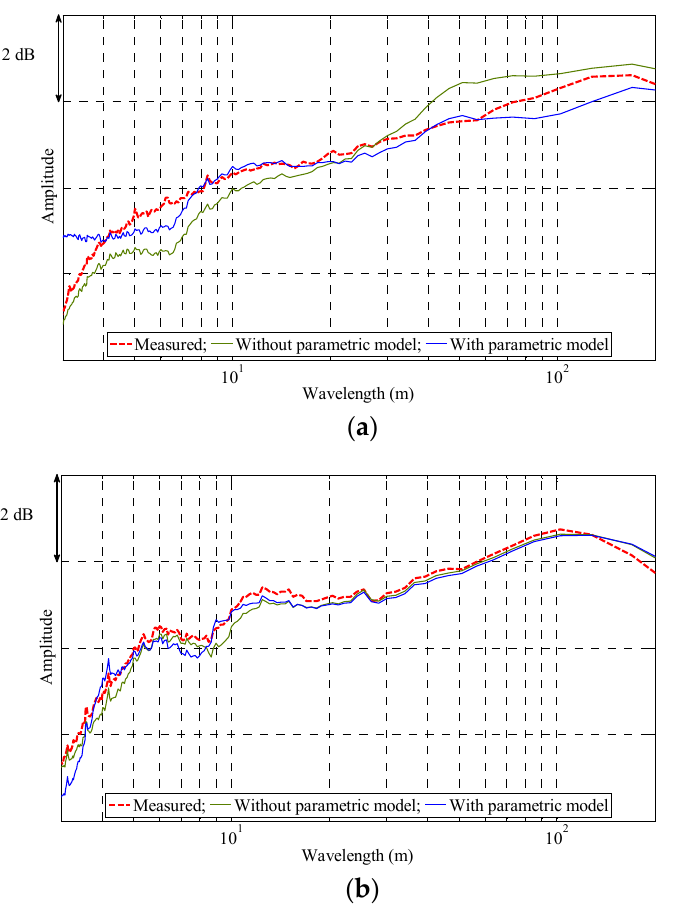
Figure 10. Estimation of track irregularities using the TGIS signal in the wavelength domain: ( a ) lateral direction; ( b ) vertical direction.